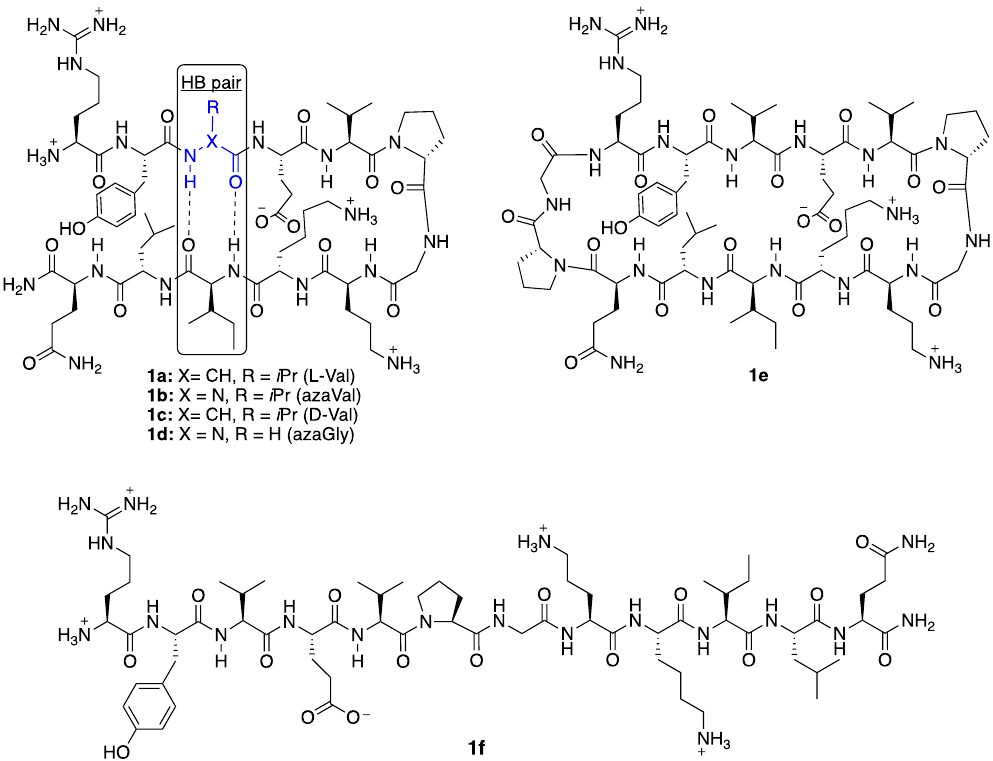
Figure 2. β-hairpin model peptide 1a [8], derivatives 1b–d , and controls 1e–f [8] under study.